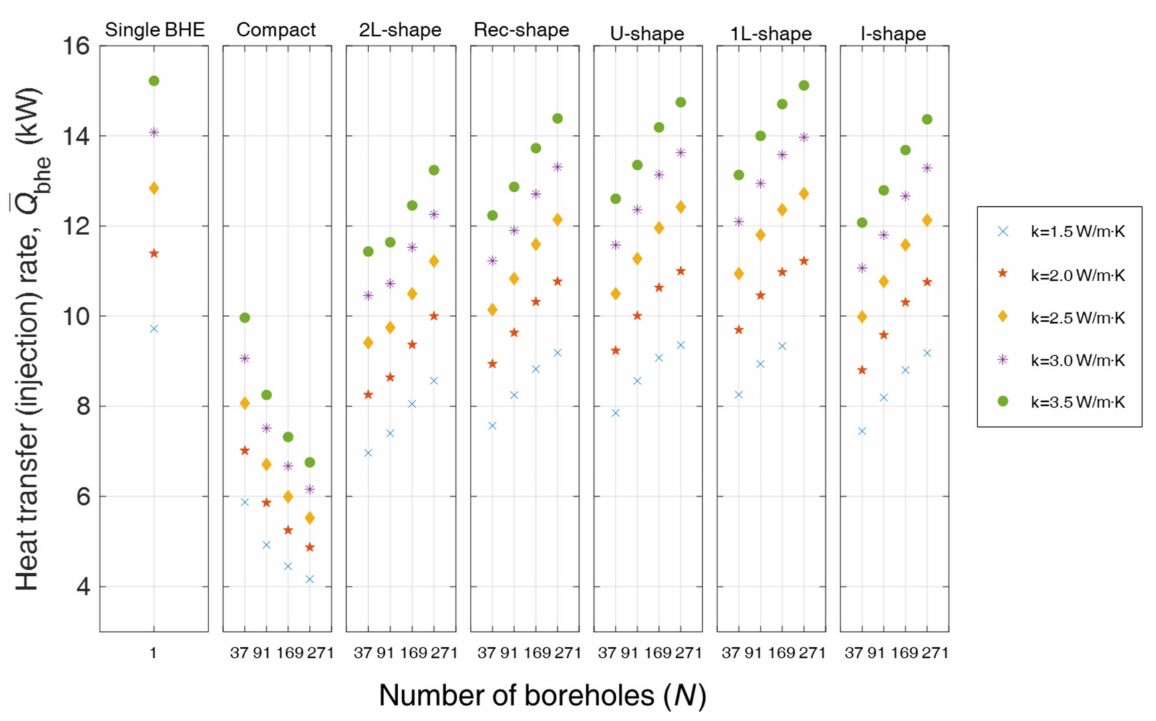
Figure 6. Variation in the heat transfer rate ( Q bhe ) for test configurations of bore field (cooling-dominant